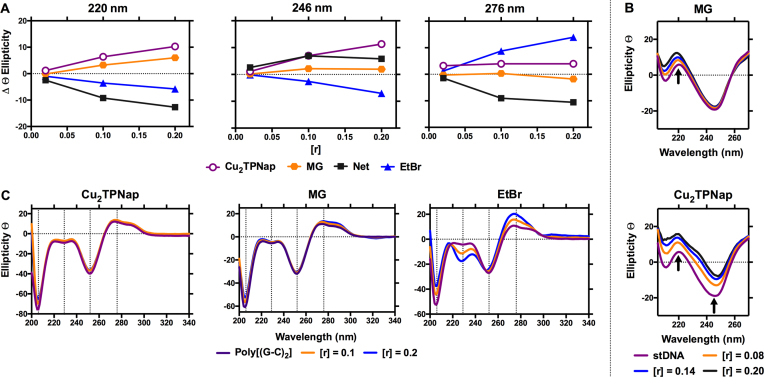
(A) Change in ellipticity of Cu2TPNap and classical major groove (MG), minor groove (net) and intercalating agent (EtBr) with respect to classical B-form stDNA at r = 0.1 and 0.2 loading ratios at 220, 246, and 276 nm; (B) increasing ratios of MG and Cu2TPNap on stDNA; and (C) interactions of Cu2TPNap, MG and EtBr on alternating copolymer poly[d(G-C)2].